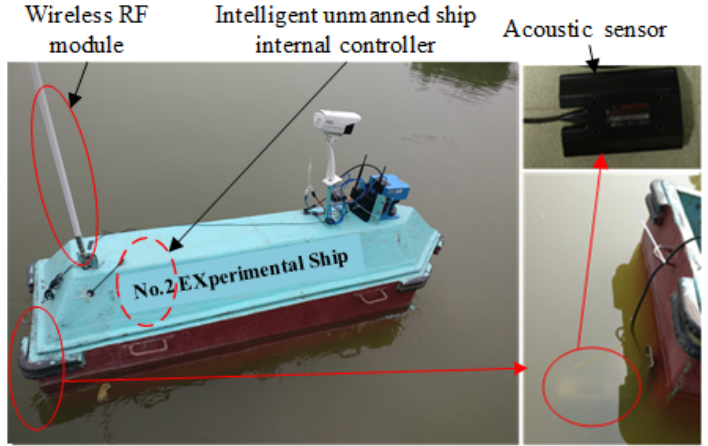
Figure 6. Pictures of experimental platform.